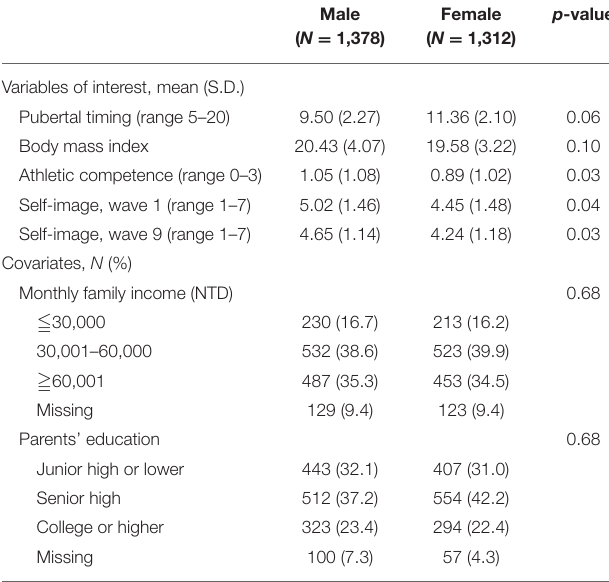
pubertal timing and BMI (see the Supplementary Materials ). TABLE 1 | Demographic information of participants ( N =